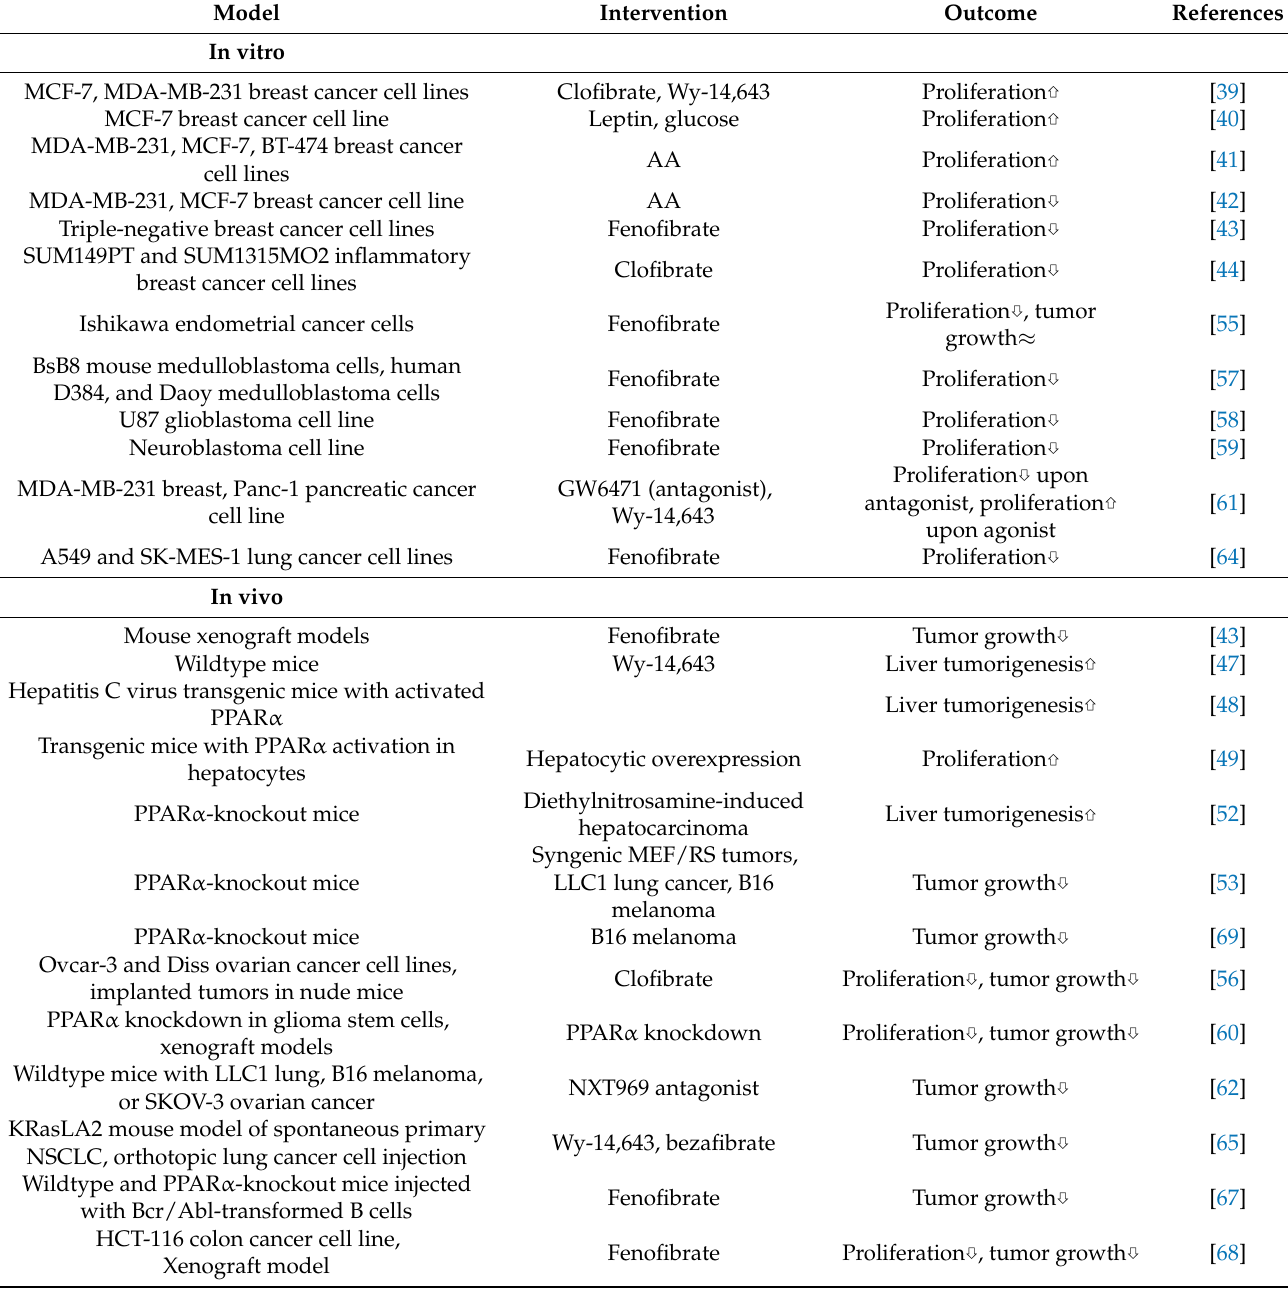
Table 1. Effects of PPARα on cell proliferation and tumor growth.